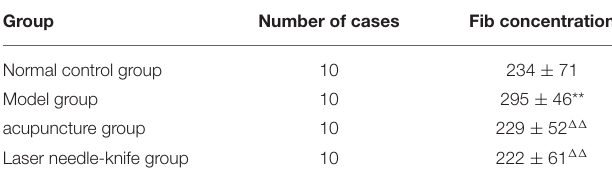
TABLE 1 | Fib concentrations in CSA rabbits ( ¯ x ± S) (Mg